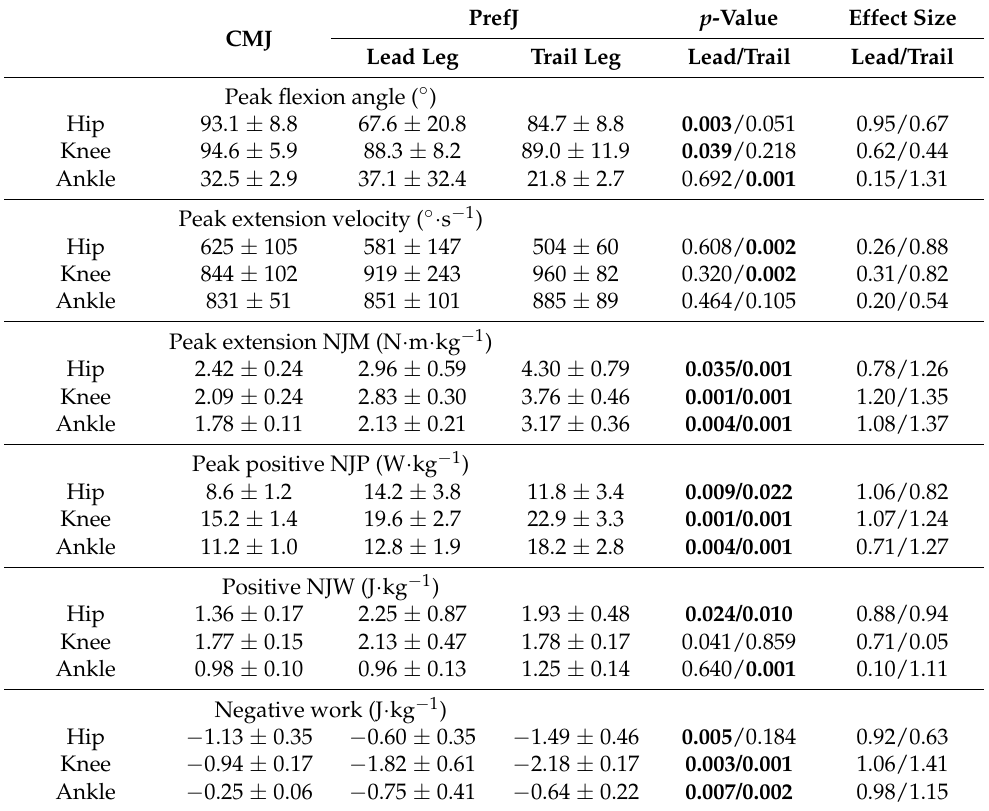
Table 2. Mean ± SD joint-level biomechanical parameters during the countermovement (CMJ) and preferred-style (PrefJ) jumps. PrefJ p -Value Effect Size CMJ Lead Leg Trail Leg Lead/Trail Lead/Trail Peak flexion angle ( ◦